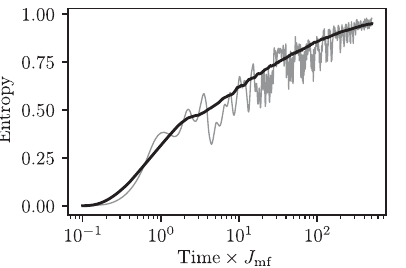
FIG. 2. Buildup of entanglement quantified by the time evolution of the second order R´enyi entropy of the few-particle simulation from Fig. 1(b). The plot shows the ensemble averaged entropy for a single realization (gray curve) and the disorder average over 1000 realizations (black curve). Since the full system remains pure, the R´enyi entropy is a measure of entanglement that increases on similar timescales to the maximal 2 Þ value of S ð ¼ 1 as the magnetization relaxes to zero. i